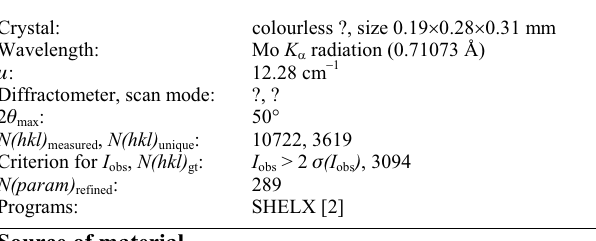
Table 1. Data collection and handling.